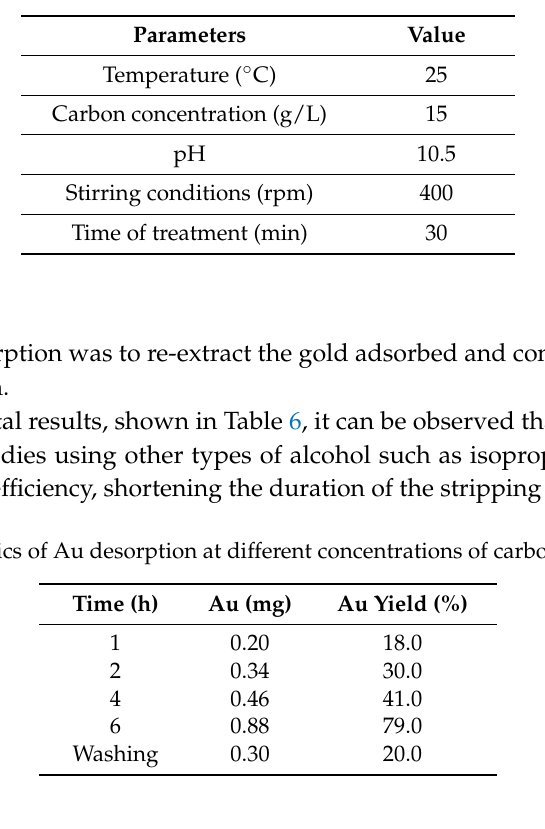
Table 5. Best process parameters of gold adsorption on activated carbon.